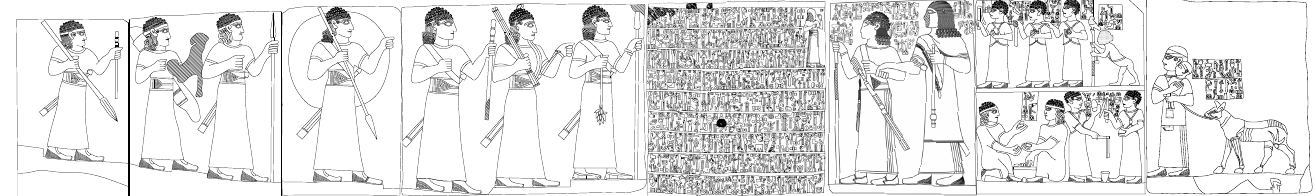
Figure 2. Rollout of the Royal Buttress reliefs (drawing by Elia Bettini).